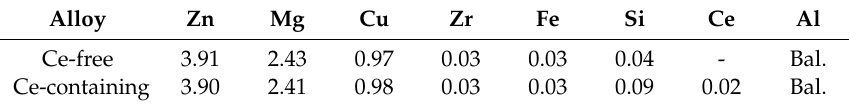
Table 1. Chemical composition of investigated alloys